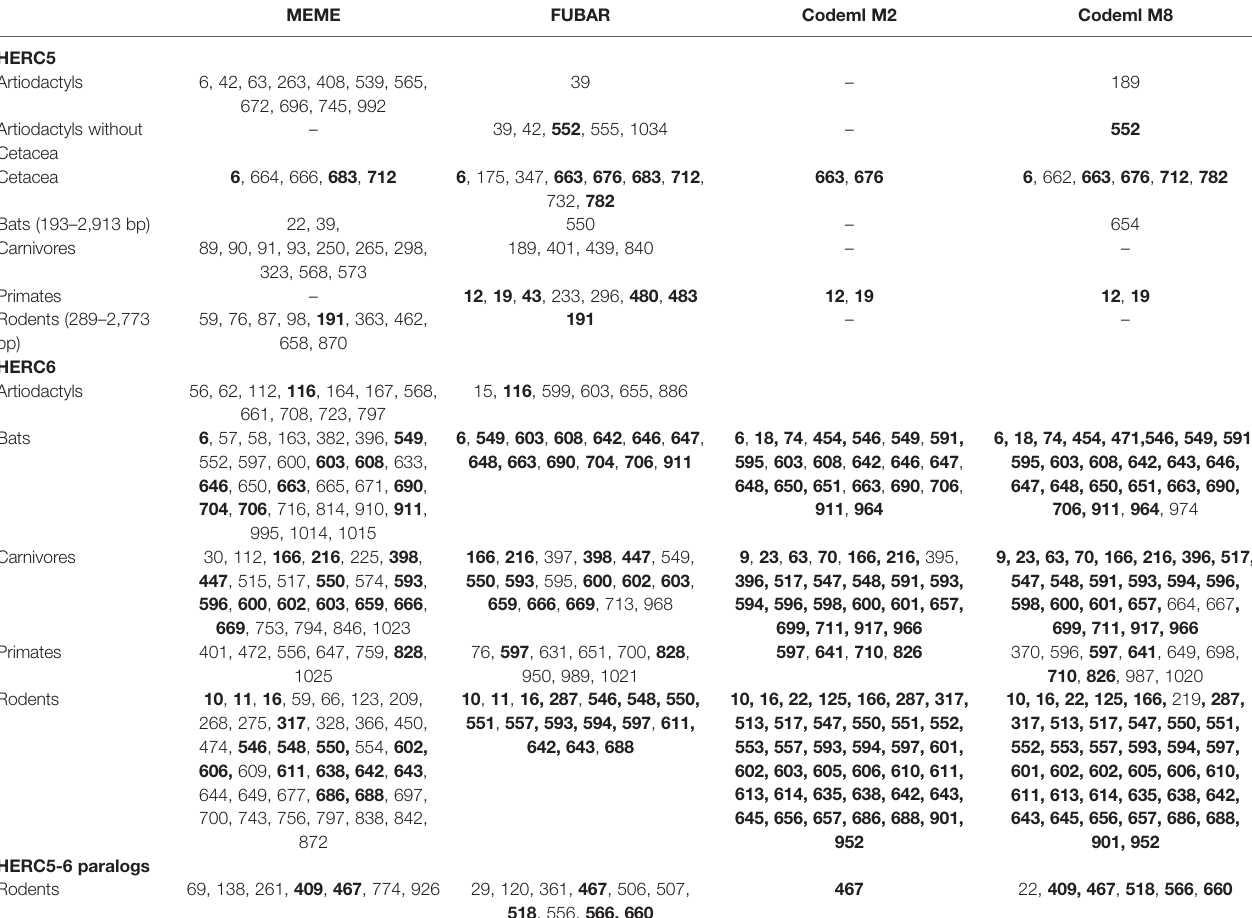
TABLE 2 | Positively selected codons in mammalian HERC5 , HERC6 and HERC5/6